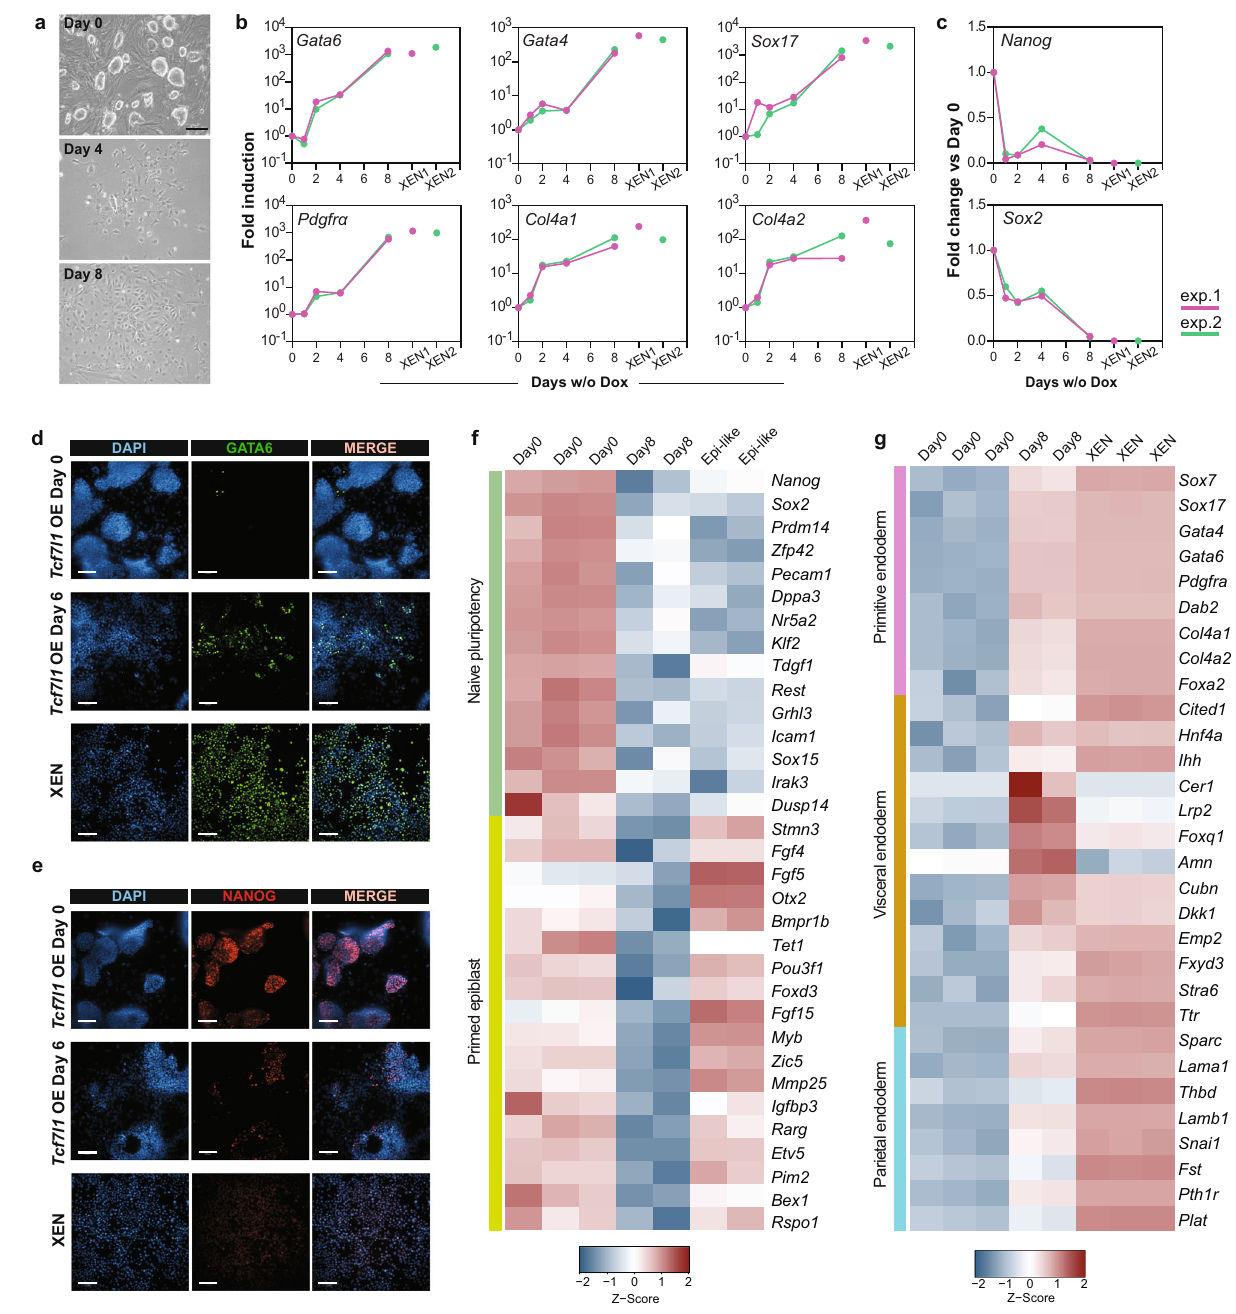
Fig. 4 | Tcf7l1 expression is suf fi cient to drive PE cell fate speci fi cation. a Representative BF images of Tcf7l1 -OE-mESCs cultured with Dox (D0) or without Dox(D4andD8)from3independentexperiments.Scalebar=50 μ m. b qRT-PCRof PE markers at indicated time points of Tcf7l1 OE from 2 independent experiments (pink and green lines). Expression levels of each gene is shown for XEN cells from thecorrespondingexperiment(pinkandgreendots).Allvaluesarereportedasfold change relative to Day0. The x -axis reports log 10 scale. n =2 independent experi- ments, see Source data fi le. c qRT-PCR of pluripotency markers at indicated time points of Tcf7l1 OE from 2 independent experiments (pink and green lines). Expression levels of each gene is shown for XEN cells from the corresponding